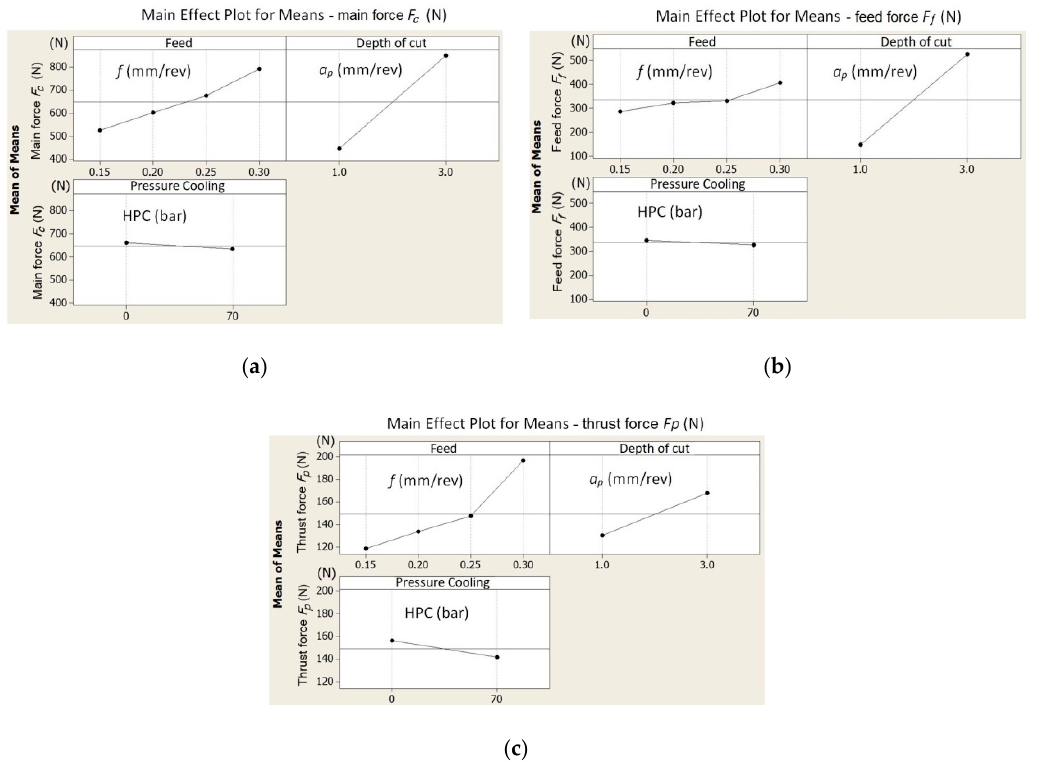
Figure 6. The influence of the cutting data on the values of the total cutting force components: ( a ) F c , ( b ) F f , and ( c ) F p .